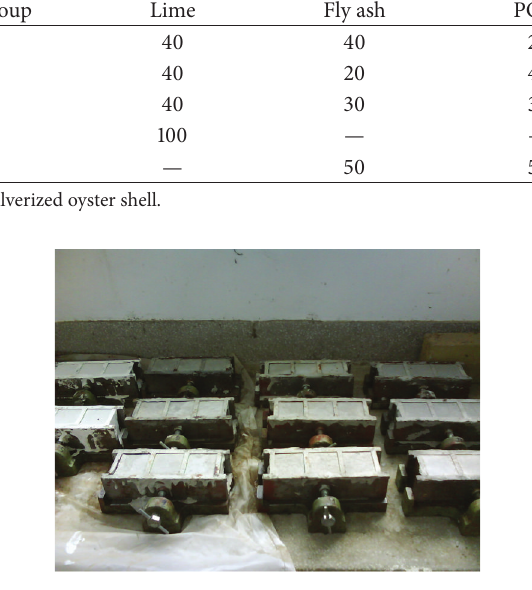
Figure 1: Cubic specimens in the study.